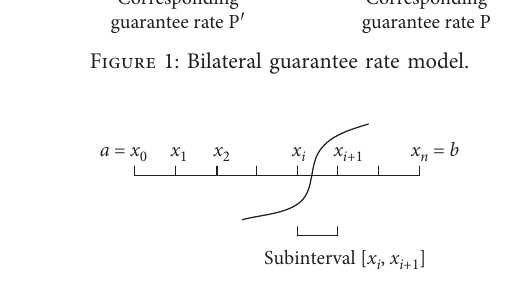
Figure 2: Stepwise search method sketch.